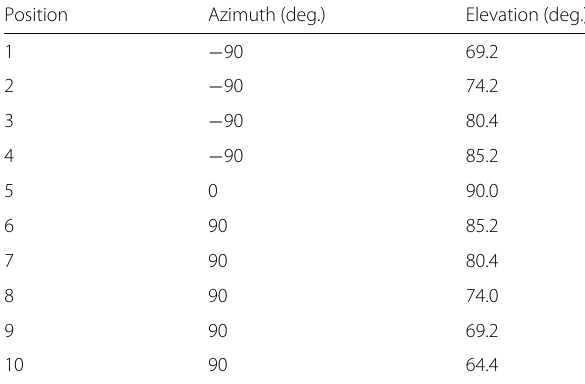
Table 2 AMISR-14 pointing